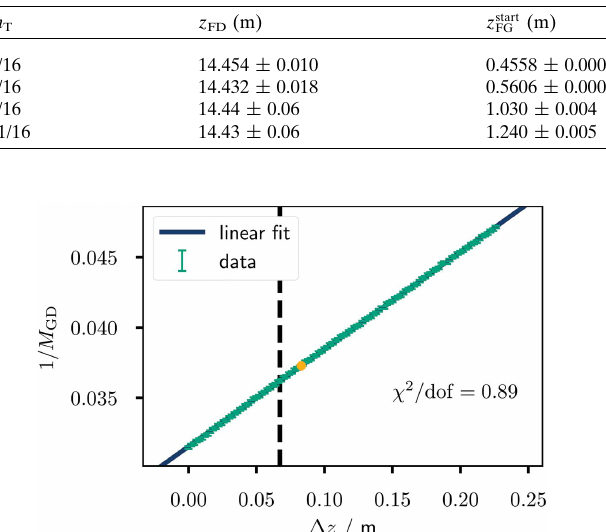
Figure 2 Linear fit to the inverse grating magnification for the grating scan around the fractional Talbot order m T = 5/16 plotted against the displacement (cid:2) z as introduced in equation (2). The focus-to-detector and the focus-to- grating distance determined from the fit can be found in Table 1, together with the results for the other three realized Talbot orders. The theoretically expected position for a (cid:3) (cid:2) -shifting grating is indicated by the vertical dashed line. The orange dot marks the grating position used in the subsequent imaging